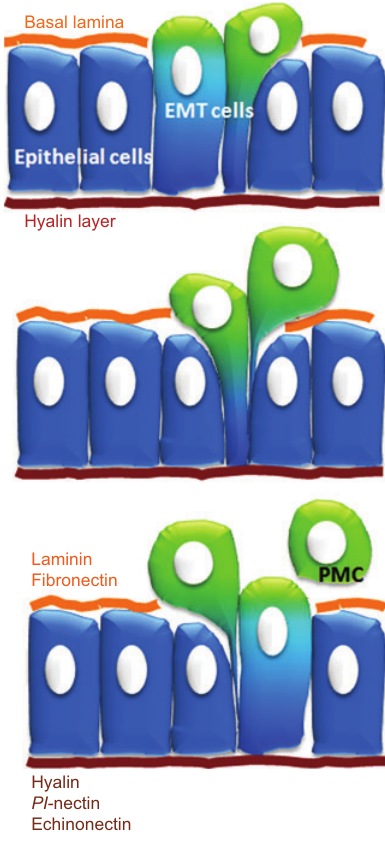
Figure 2 Ingression of